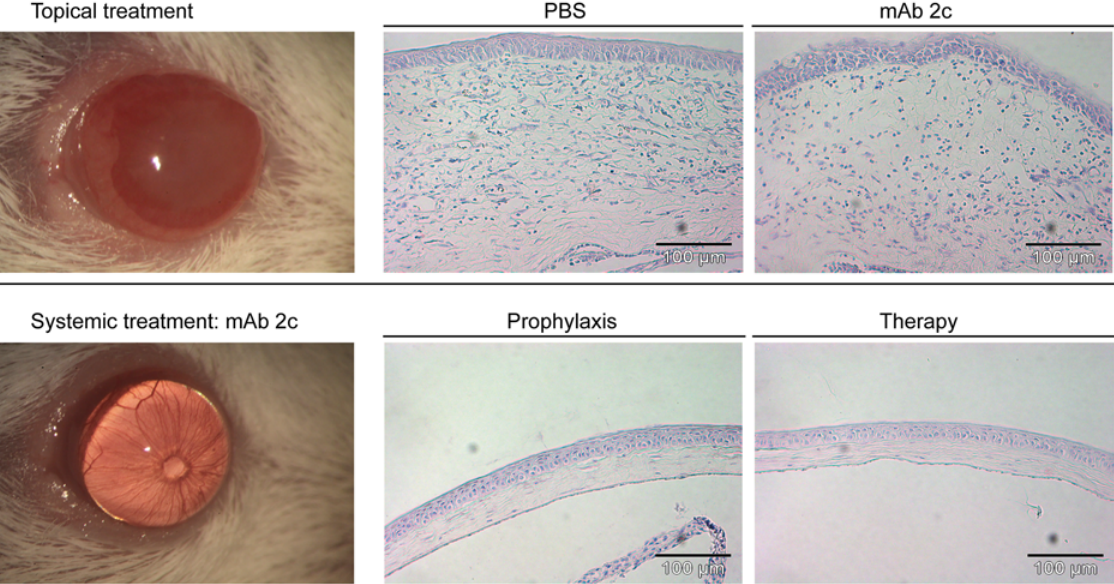
Figure 4. Potent reduction of the severity of HSV-mediated corneal damage by mAb 2c. Groups of ten mice were either topically or systemically treated with mAb 2c. Pictures representative for topically PBS-treated mice (A) or systemically treated mice (B) were taken at day 14 post infection. Pathological changes of the cornea are shown as representative corneal sections from each group. Hematoxylin-eosin staining. Magnification: 120x. Scale bars: 100 μ